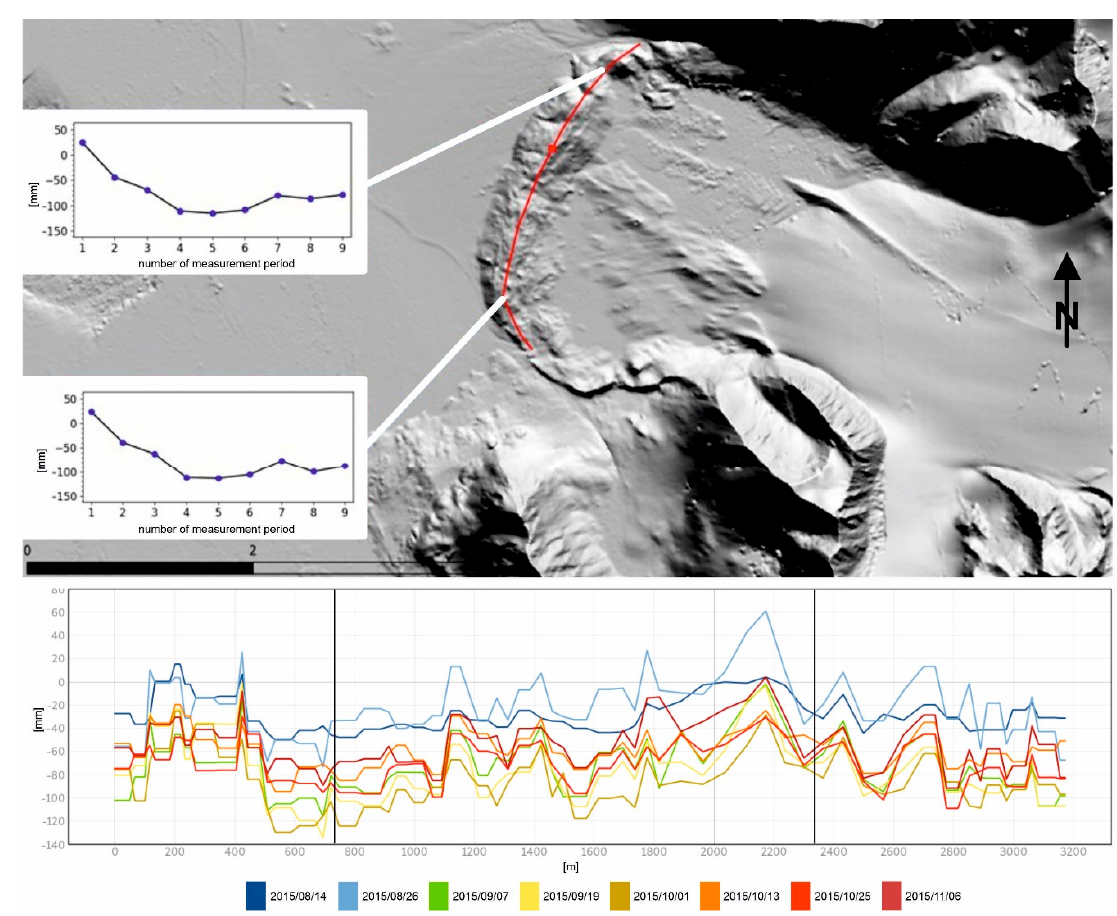
Figure 8. Longitudinal profile of the InSAR-based DTM displacement locations and values. Locations of points showing the greatest changes over 9 measurement periods.